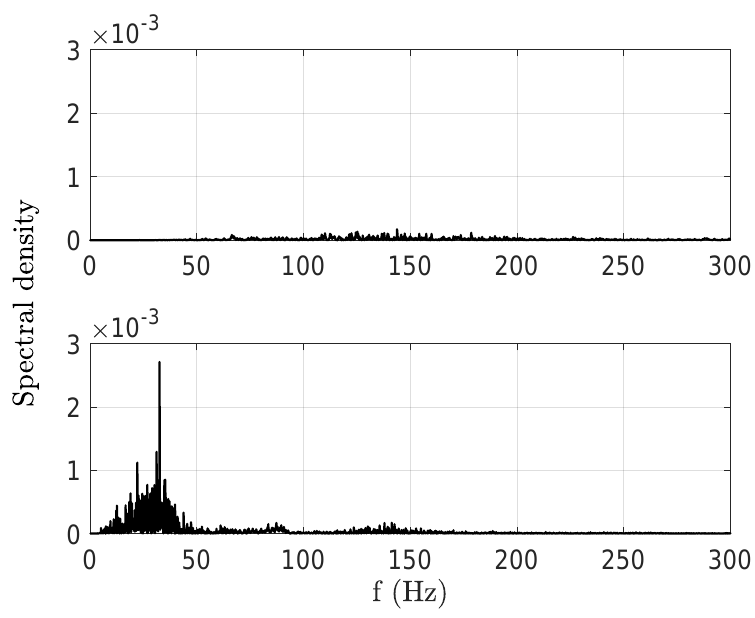
Figure 2. Frequency spectra of the time series intervals before ( upper panel ) and immediately after ( lower panel ) the computed arrival time of the hydro-acoustic